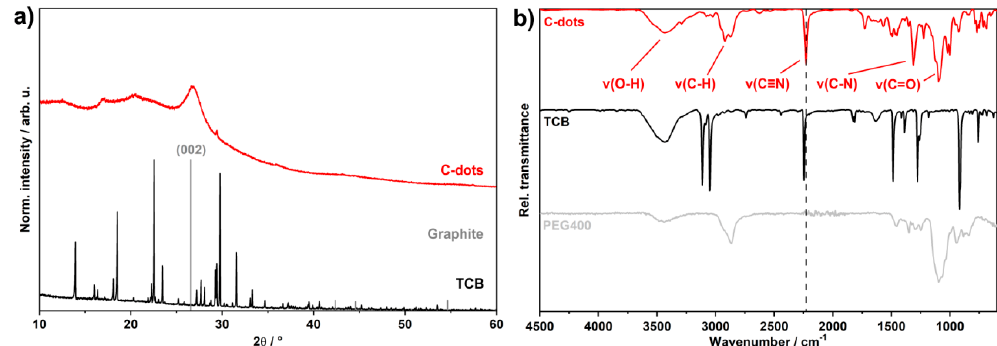
Figure 3. Chemical composition of the as-prepared C-dots: ( a ) X-ray diffraction pattern with pure TCB (starting material) and graphite (ICDD-No. 00-056-0159) as references; ( b ) Fourier-transform infrared spectra with pure TCB and pure PEG400 as references.